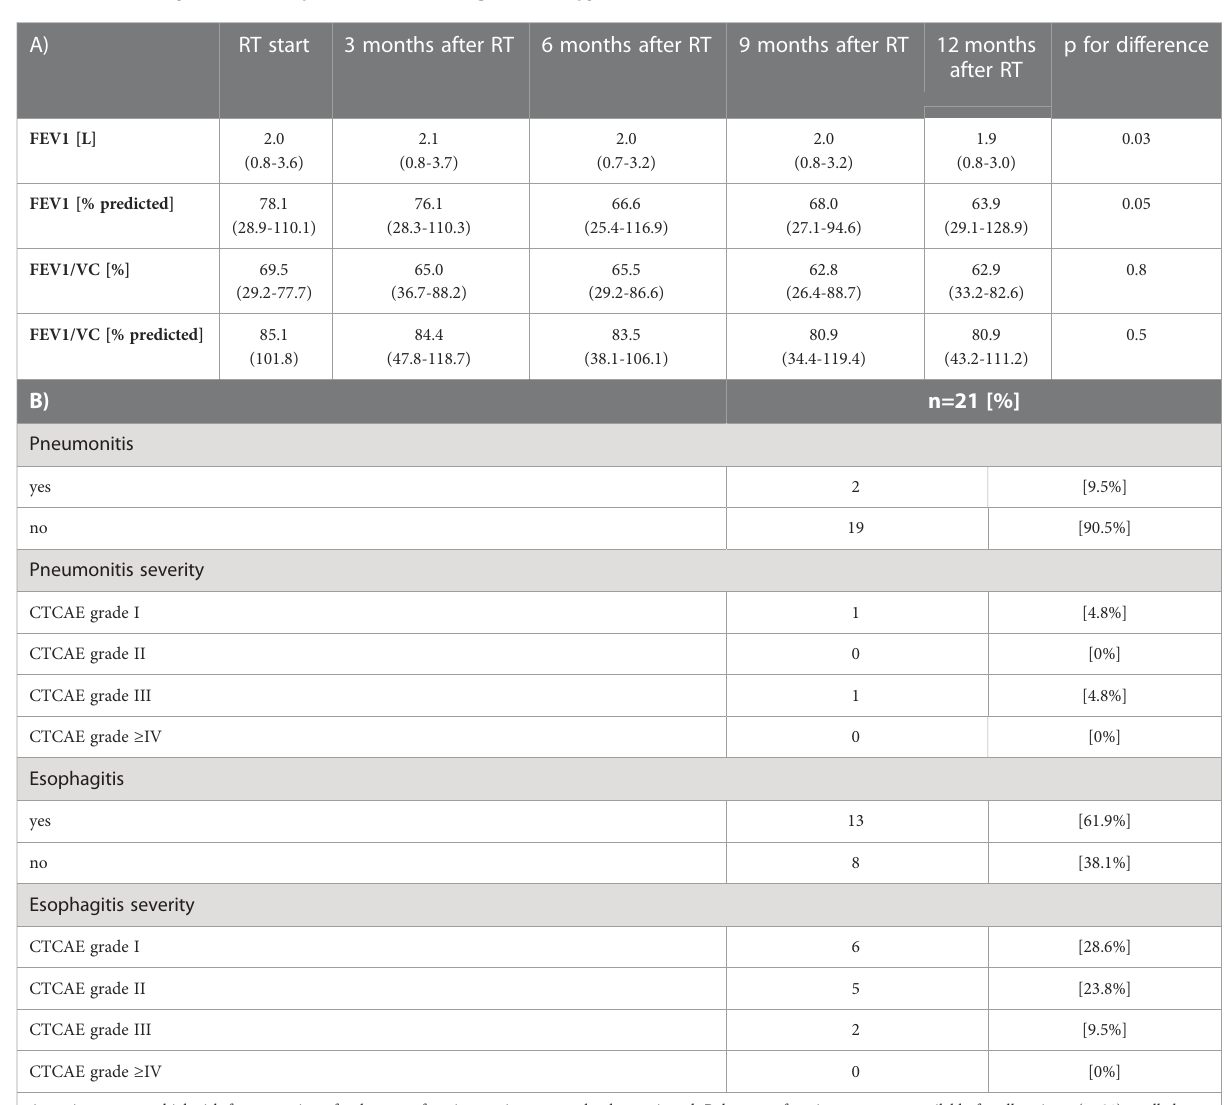
TABLE 3 Pulmonary function and pneumonitis following